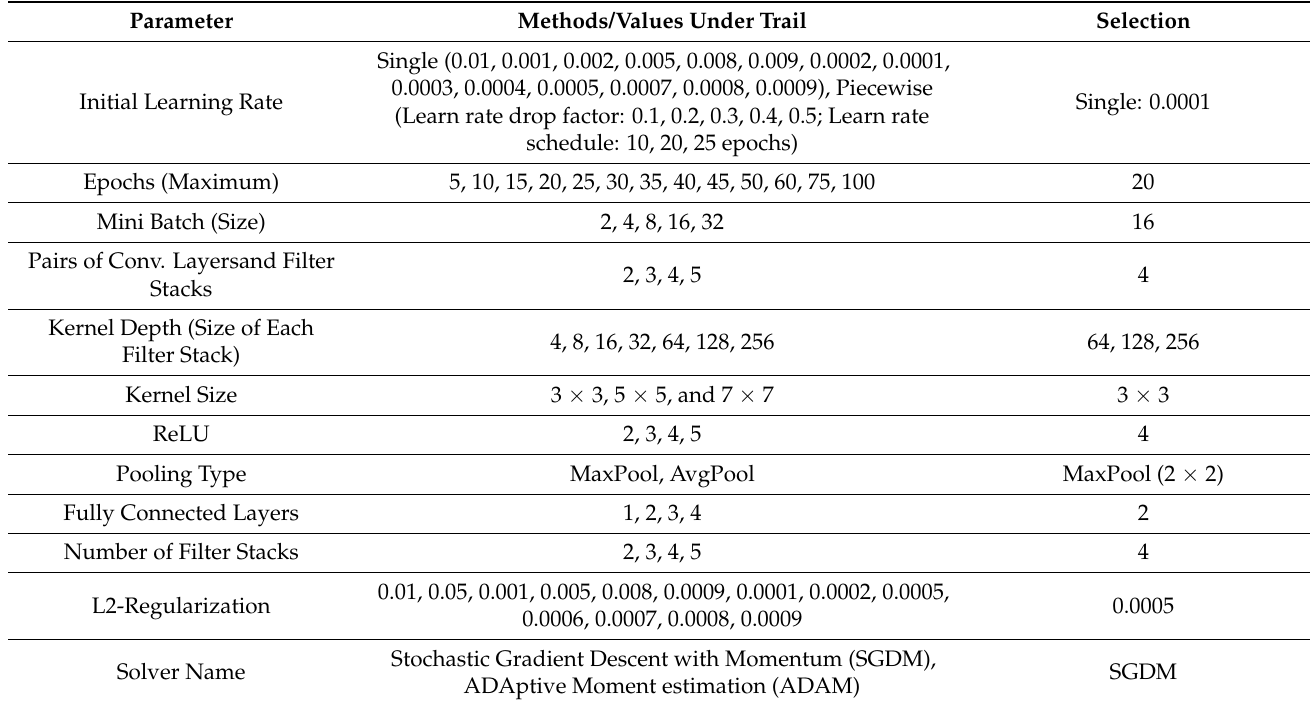
Table 3. UL-DLA parameters for dynamic features